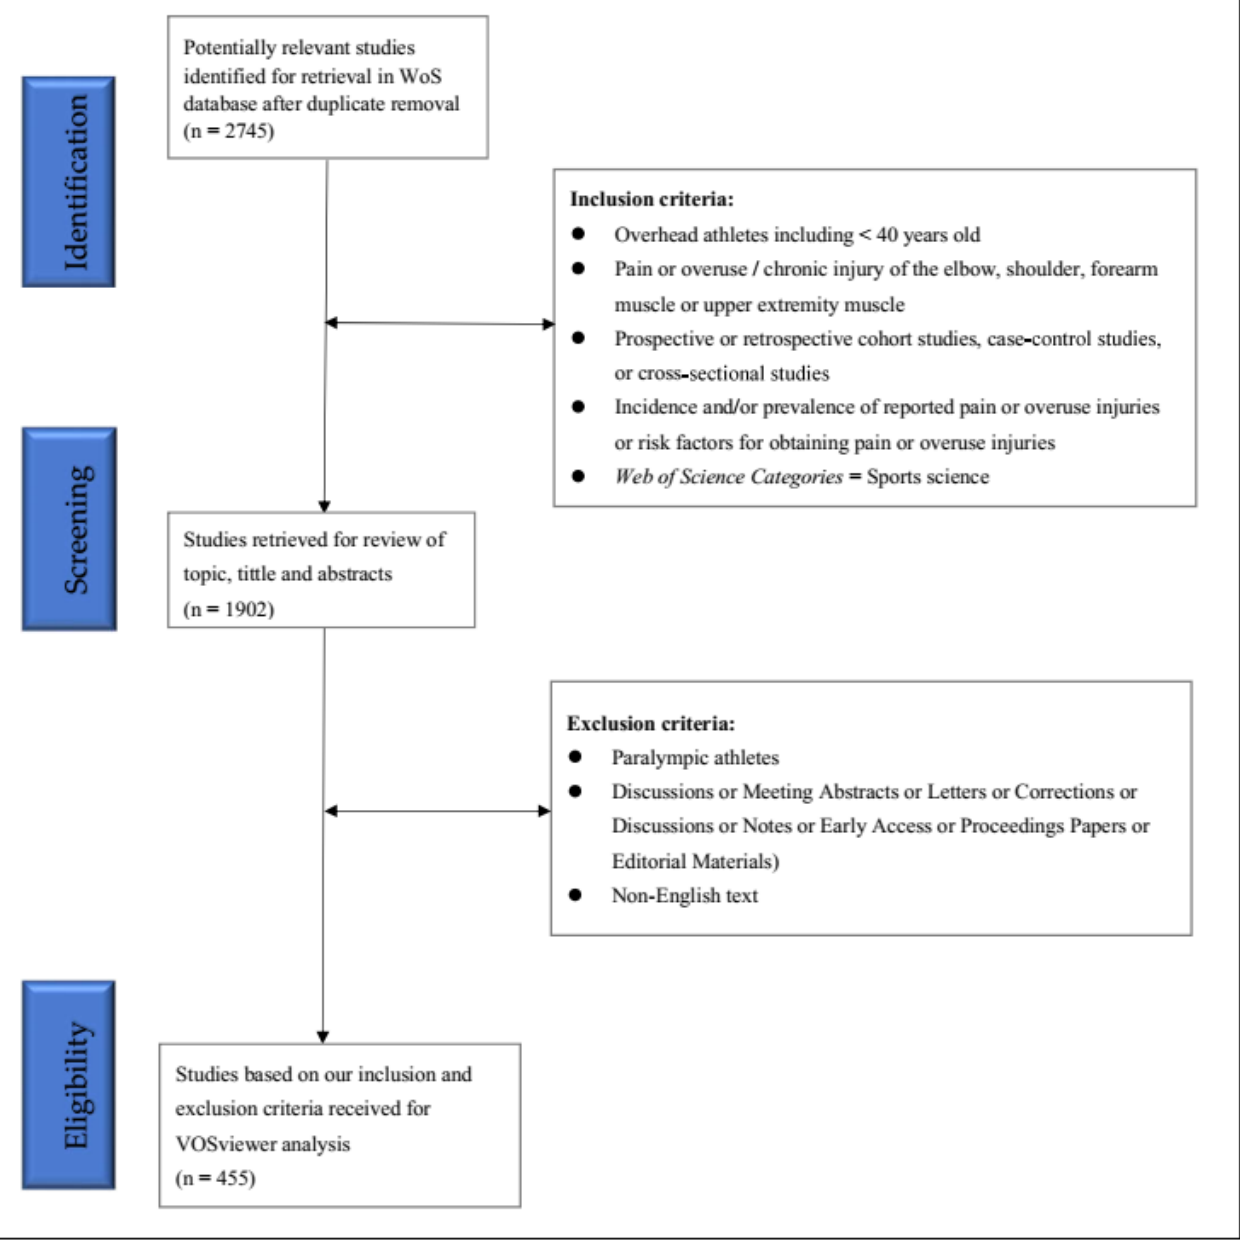
Figure 1. Flowchart of the preferred reporting items for VOSviewer analysis.